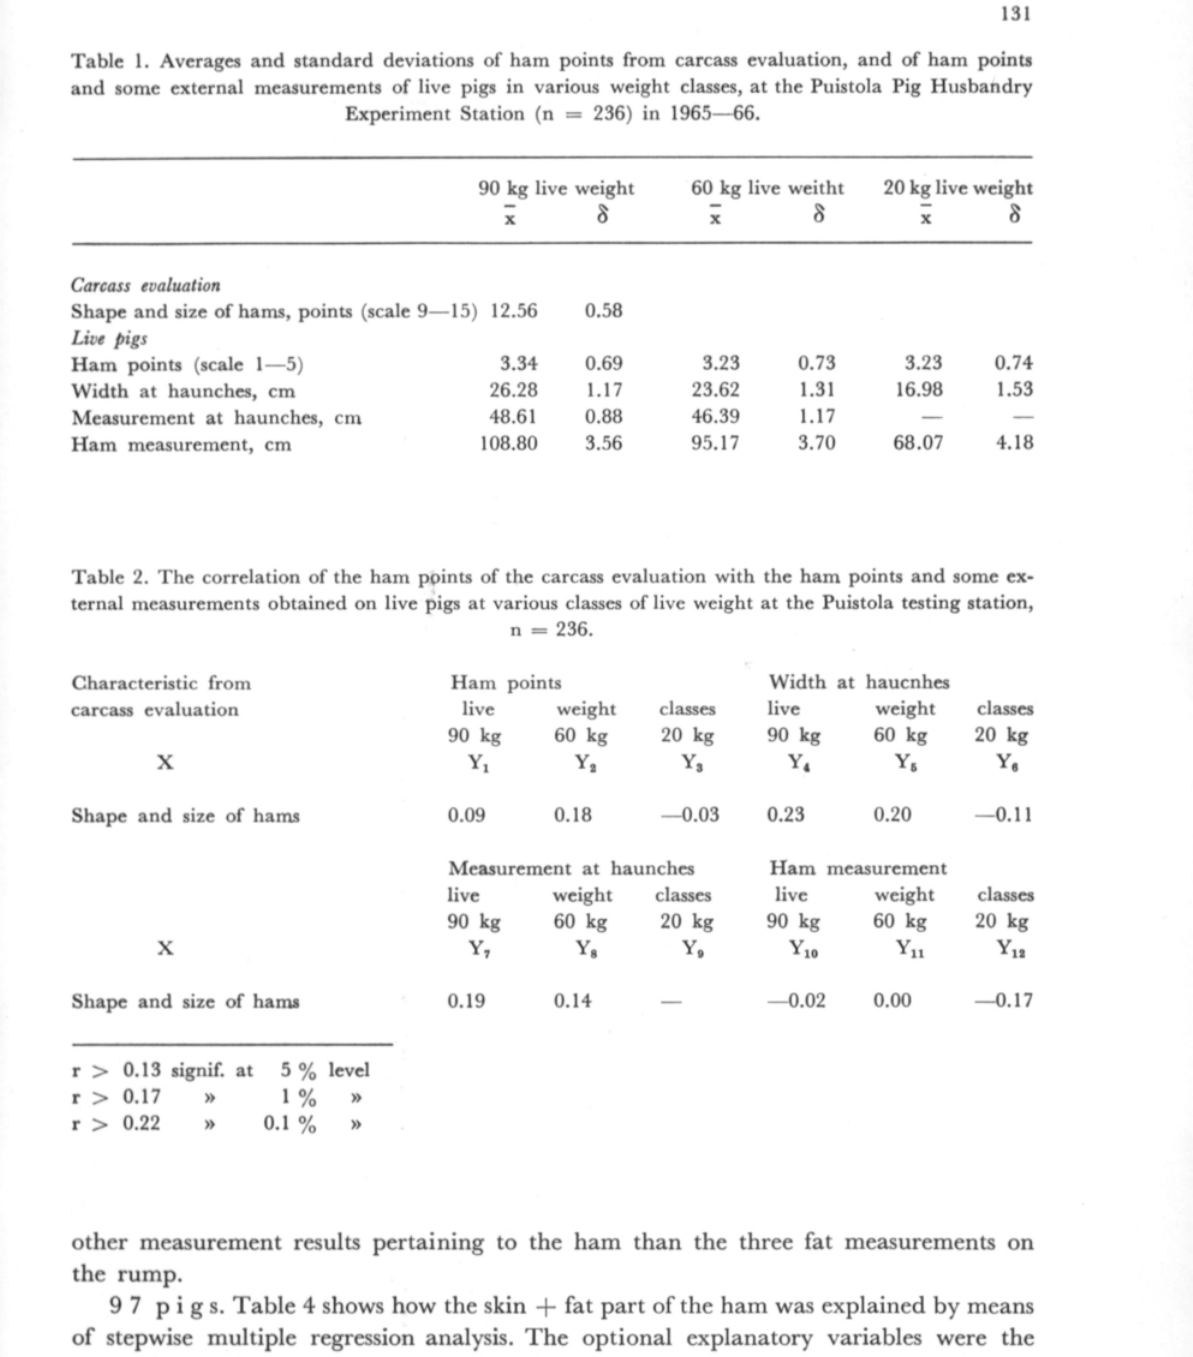
Table 1. Averages and standard deviations of ham points from carcass evaluation, and of ham points and some external measurements of live pigs in various weight classes, at the Puistola Pig Husbandry Experiment Station (n = 236) in 1965—66.